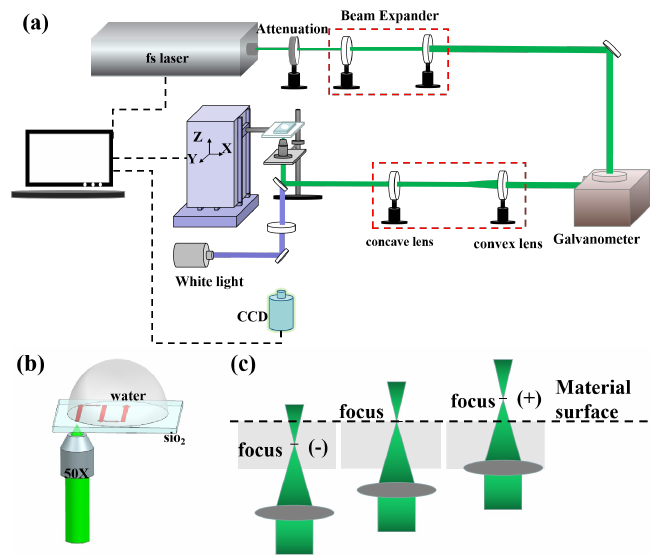
Figure 1. ( a ) Schematic diagram of the femtosecond laser processing system. ( b ) Enlarged view of the laser processing section. ( c ) Schematic diagram of the definition of the out-of-focus state.